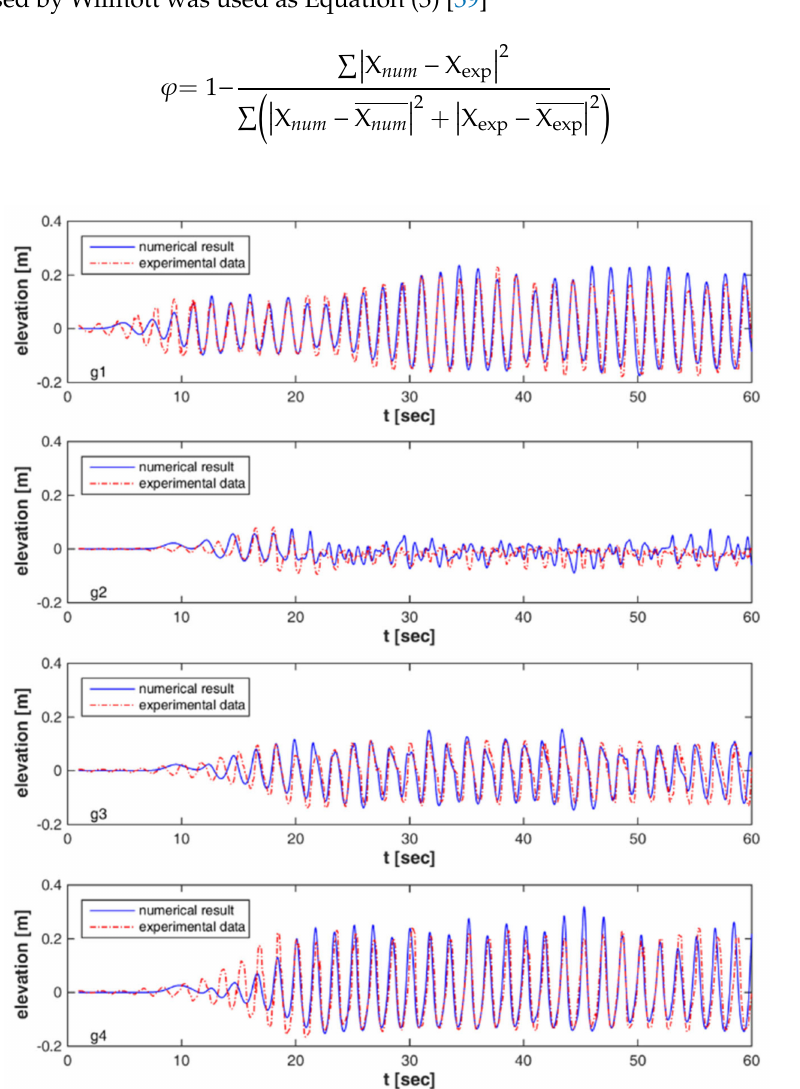
Figure 2. Comparisons of the surface elevation in regular wave condition (H = 0.19 m, T = 1.67 s) between numerical results (dashed line) and experimental data (solid